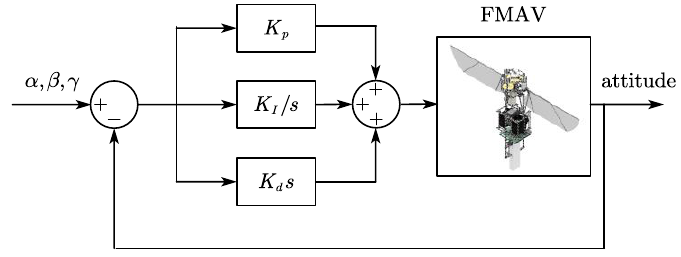
Figure 12. The attitude control PID diagram for the prototype.